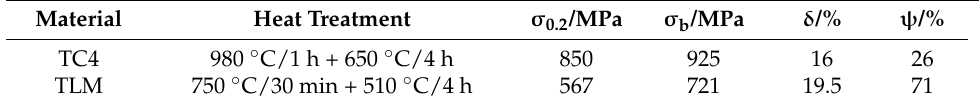
Table 2. The heat treatment and mechanical properties of TC4 and TLM.